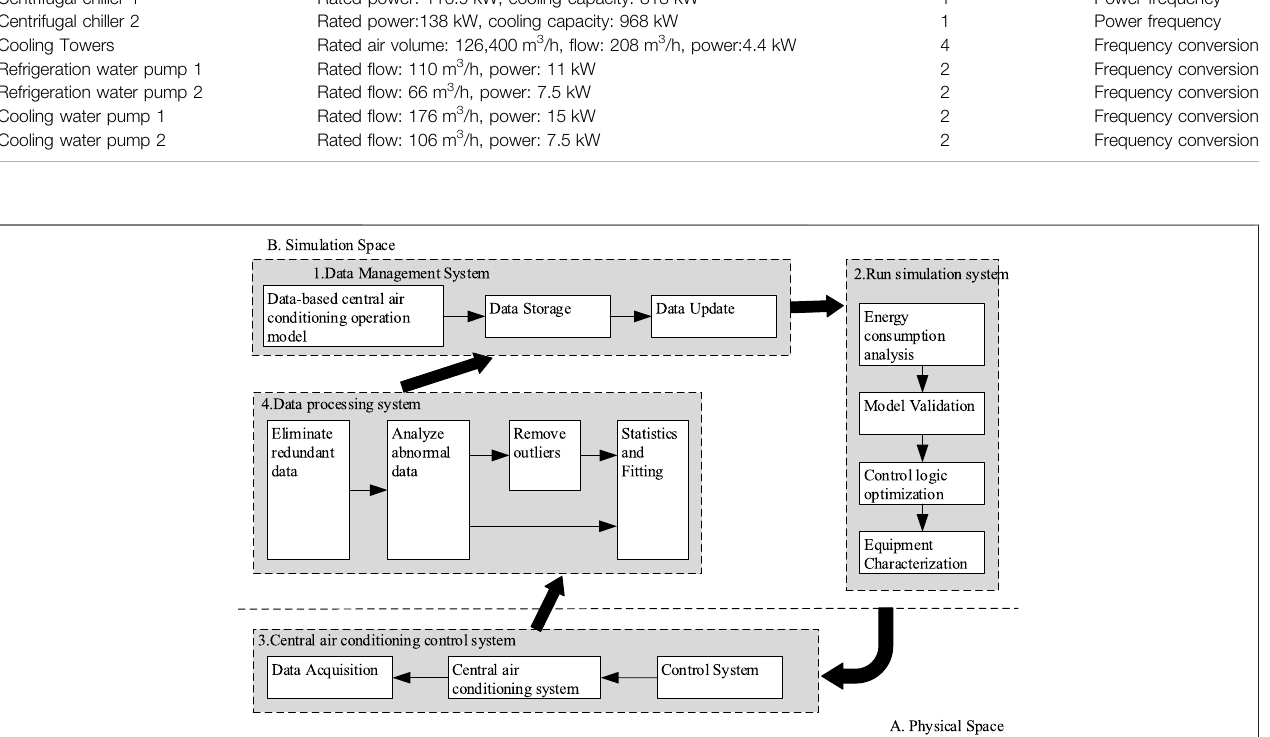
FIGURE 9 | The structure of data acquisition and control